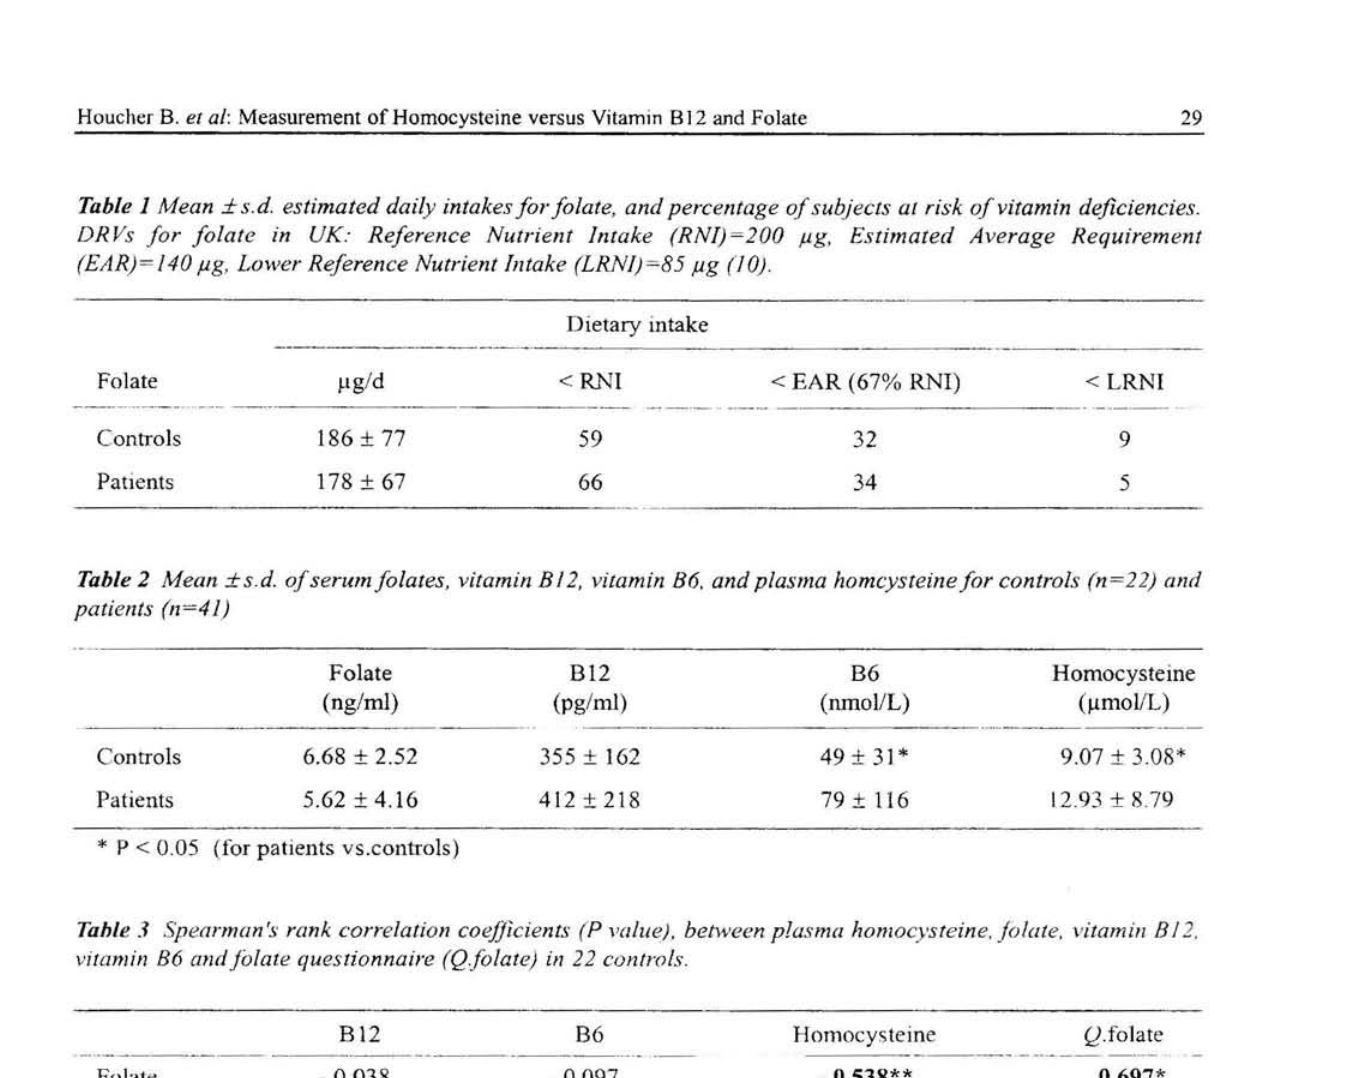
Table 1 Mean ±s.d. estimated daily intakes for folate, and percentage of subjects at risk of Vitamin deficiencies.